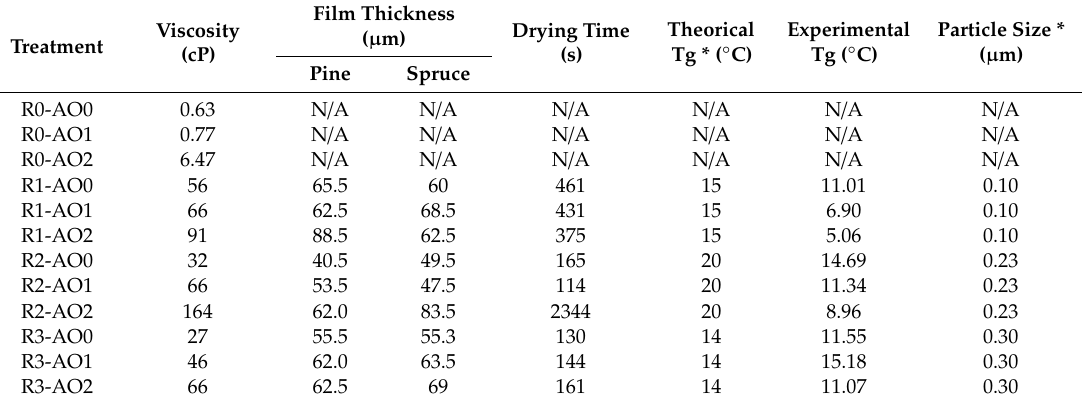
Table 6. Properties of the treatment solutions (at 65 ◦ C) and of the dry coatings.